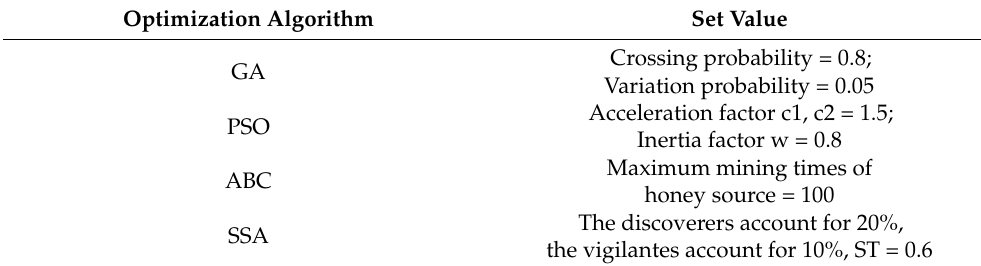
Table 2. Optimization algorithm parameter setting.